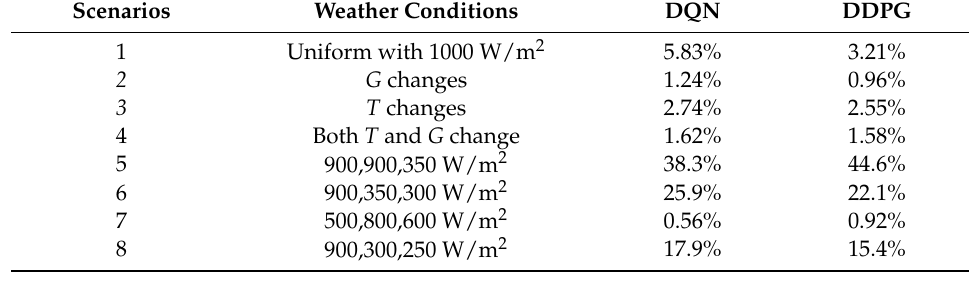
Table 3. MPPT tracking e ffi ciency of the proposed methods under various weather conditions compared to P&O.